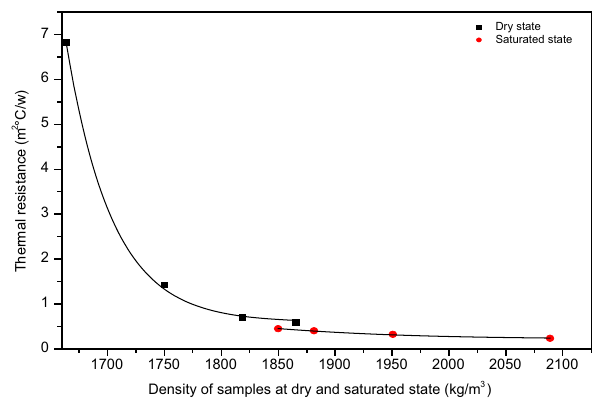
Fig. 5 Thermal resistance of lightened concrete as function of density at dry and saturated state